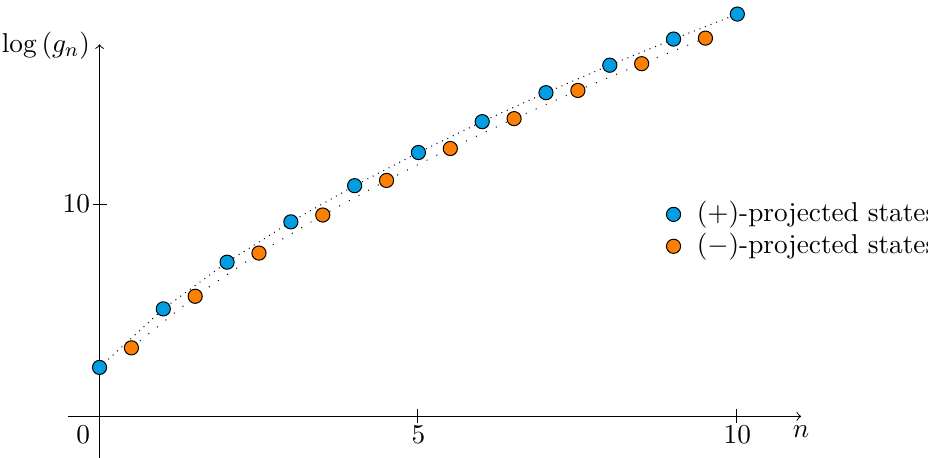
Figure 4 . The net number of physical degrees of freedom for the lightest energy levels in the closed- string sector of the type 0 0 B theory, defined as g , at the n -th mass level. All states are bosonic, n and each point corresponds to states with mass M 2 = 4 n/α 0 , with n = 0 , 1 / 2 , 1 , . . . , 10 . There is a n clear alternance between states receiving a positive contribution from both the torus and the Klein bottle, i.e. undergoing the ‘ (+) -projection’, and states receiving a positive contribution from the torus and a negative contribution from the Klein bottle, i.e. undergoing the ‘ ( − )